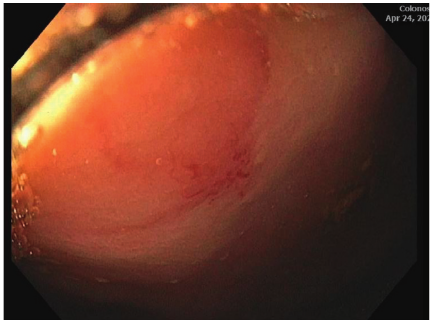
Figure 1: Arteriovenous malformation in the cecum.